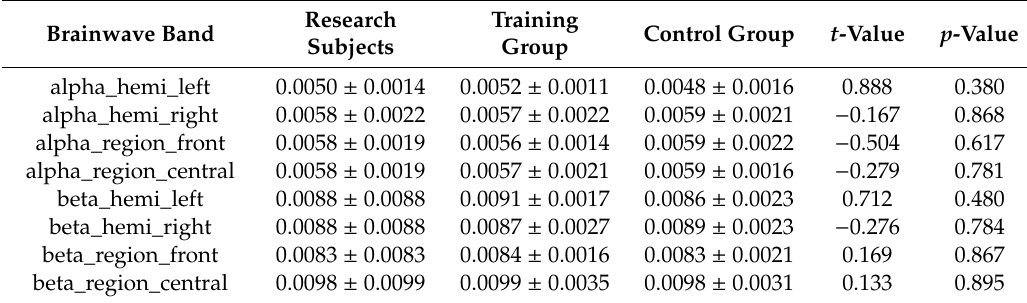
Table 11. Comparison of the alpha- and beta-wave power in all brain areas ( N = 41; X ± SD).